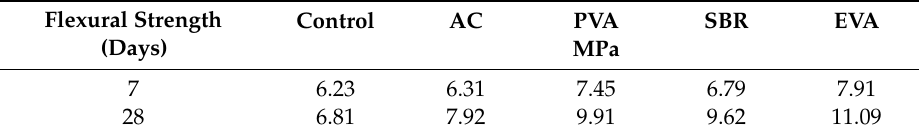
Table 6. Averaged flexural strengths measured at seven and 28